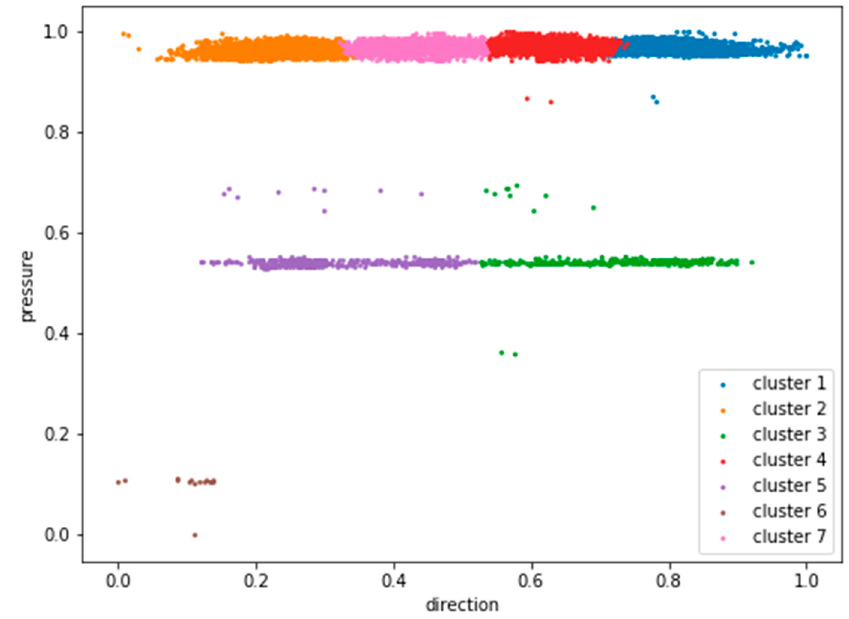
Figure 5. Scatter diagram of clustering results.